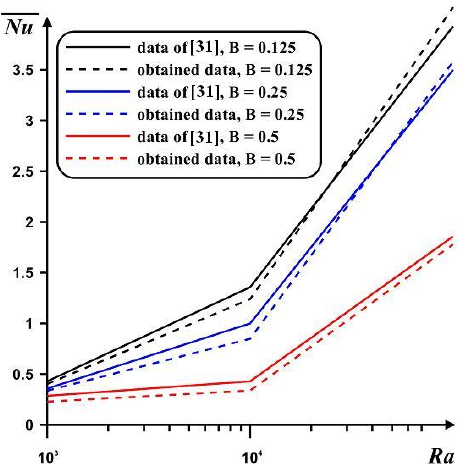
Figure 5. Mean Nu at hot border compared with computations [31] for different heights of the obstacles (B) and Rayleigh numbers. Table 1. Values of mean Nu at hot border.